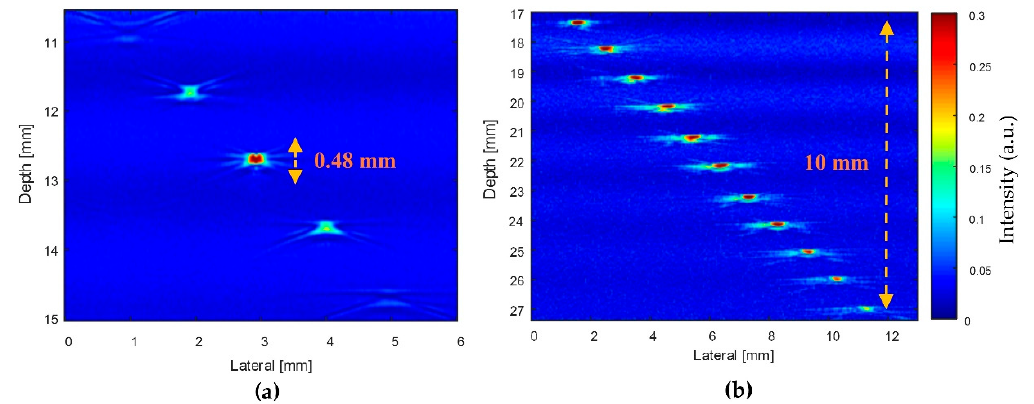
Figure 13. Ultrasound images of the wire phantoms obtained using ( a ) the SFP transducer and ( b ) the MFP transducer.